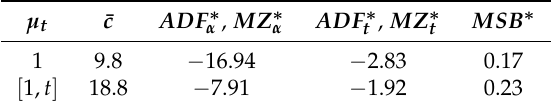
Table 1. The values of ¯ c and the associated critical values of the wavelet based tests at a 5% significance